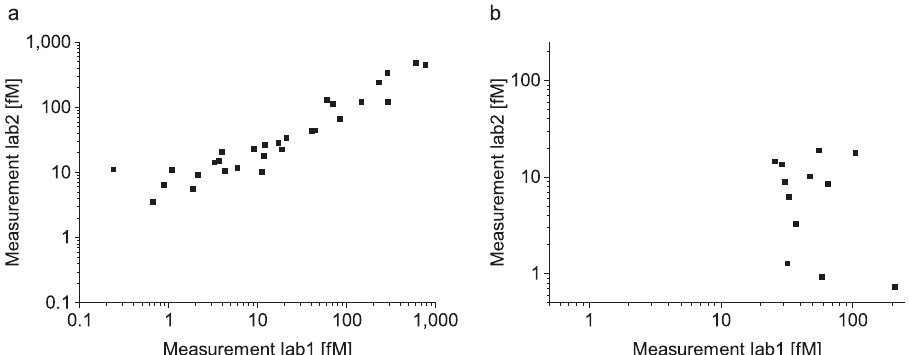
Fig. 4 Measurements of aSyn but not Tau aggregates in CSF correlated well when measured in a different laboratory. The CSF samples were measured by sFIDA by two different technicians in two different laboratories. The fi rst sFIDA experiment was prepared and run by a technician at the Forschungszentrum Jülich, while the second sFIDA was performed by another technician at the Heinrich-Heine-Universität Düsseldorf. a Concentrations of aSyn aggregates correlated well between both experiments with a Pearson coef fi cient of correlation of r = 0.95, b while for Tau aggregates no correlation was observed ( r =